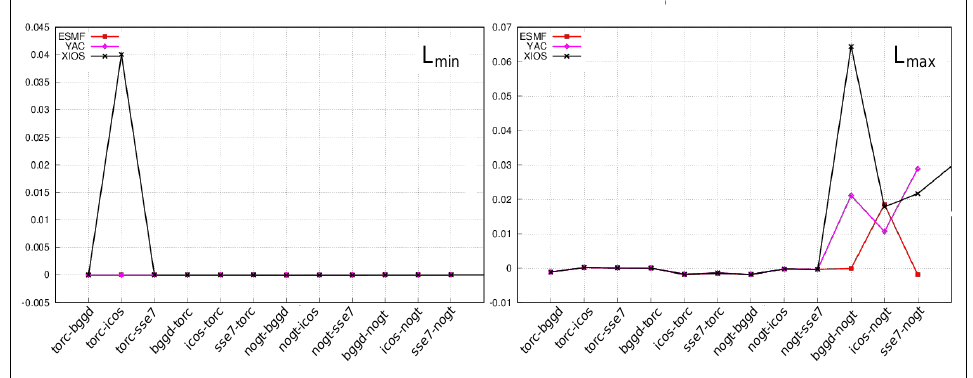
Figure 16. L min and L max for the different pairs of grids for the gulfstream function for 2nd order conservative remapping with FRACAREA normalisation.